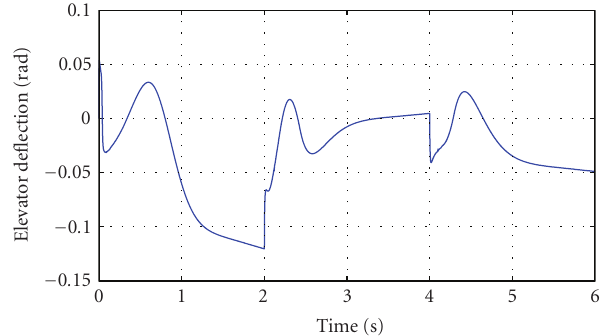
Figure 19: Tracking error with sliding mode and adaptive sliding